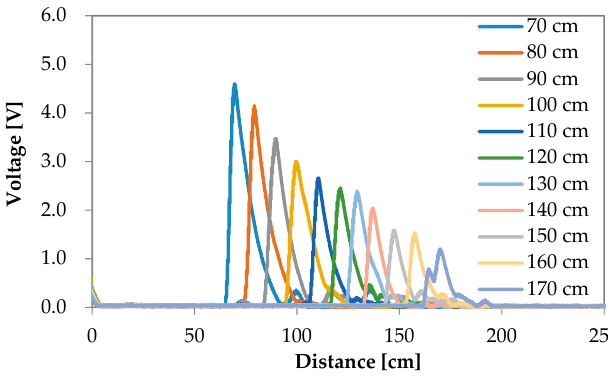
Figure 7. Experimental results of the reflection wave with respect to asphalt.